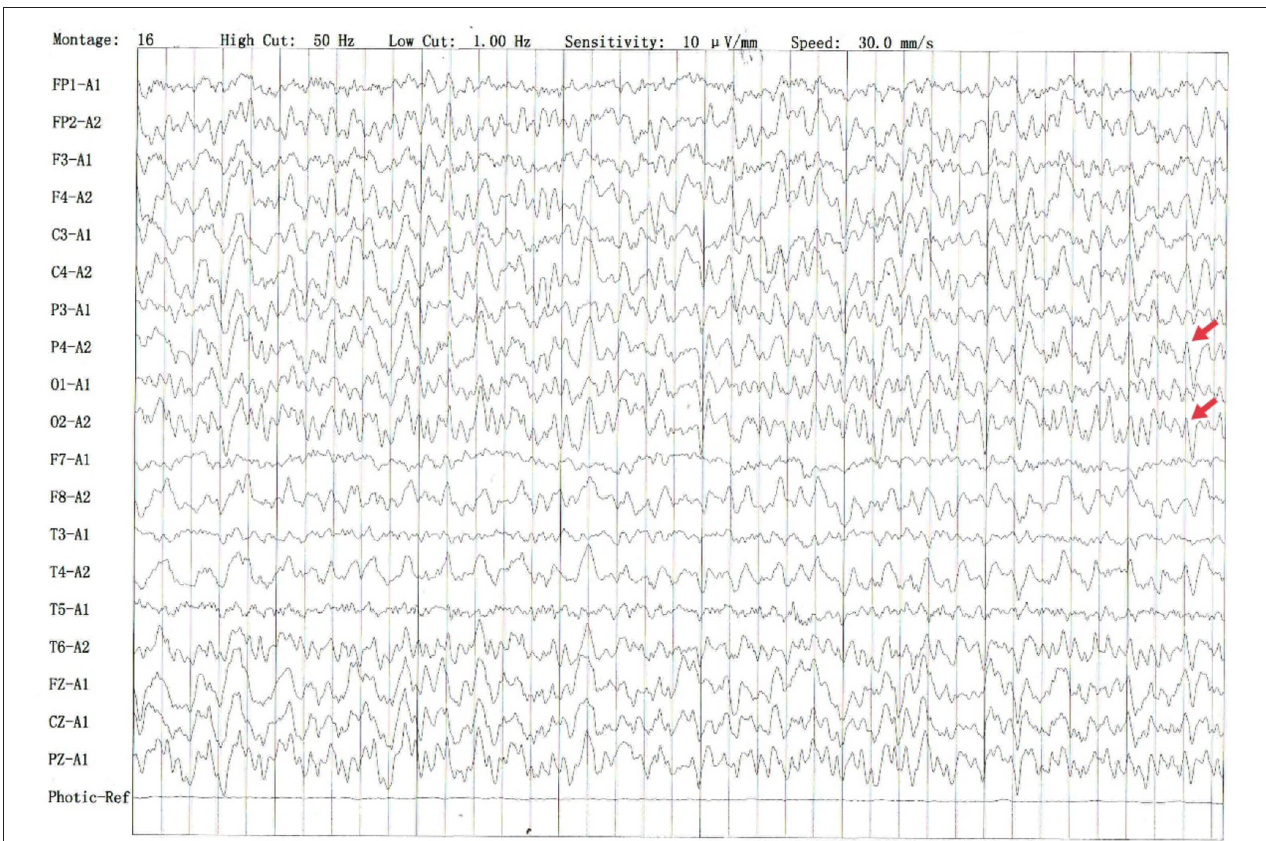
FIGURE 1 | Several irregular slow waves with medium to high amplitudes were recorded in the right temporal leads, which spread to other leads and showed sharp waves (shown by the red